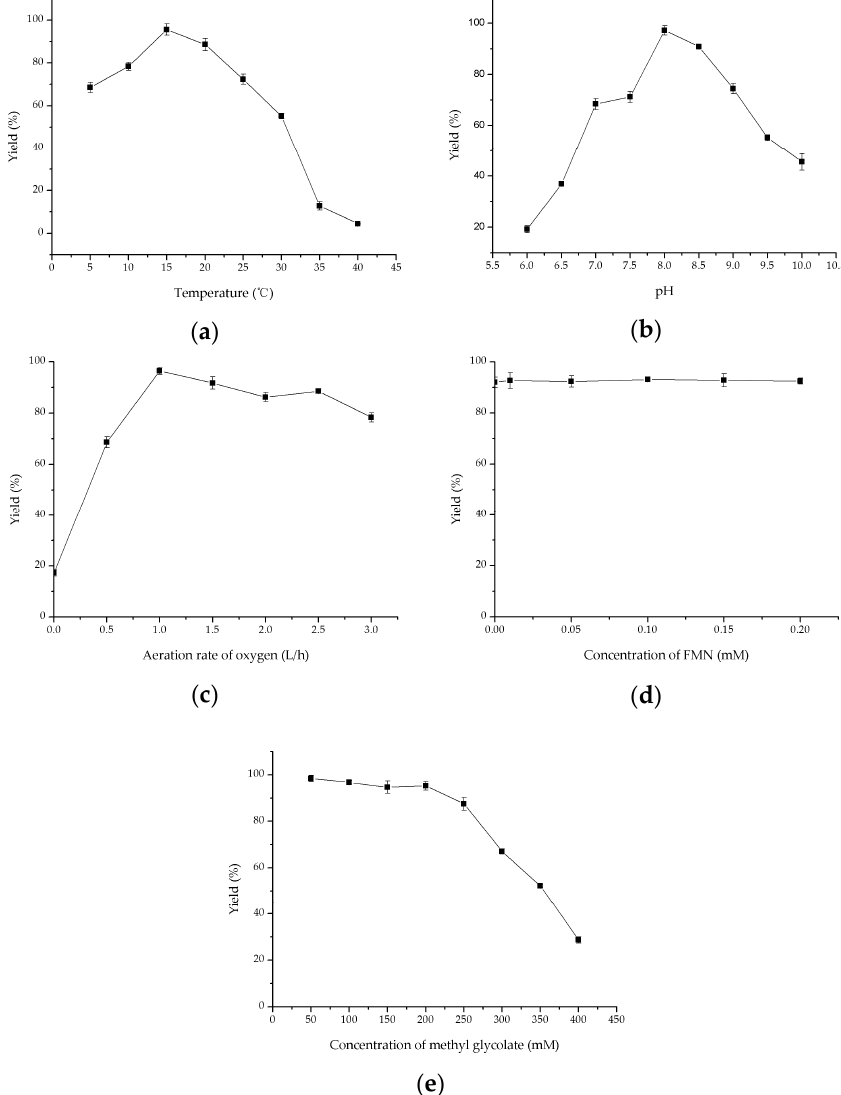
Figure 5. Factors affecting the oxidation of methyl glycolate to methyl glyoxylate: ( a ) Temperature; ( b ) pH; ( c ) the aeration rate of oxygen; ( d ) the concentration of FMN; ( e ) the substrate concentration. The reaction mixture (5 mL) contained 10 mg crude enzyme Vs HGB-GSG- So GOX mut -GGGGS- Hp CAT, 100 mM methyl glycolate, 0.01 mM FMN and 50 mM Tris-HCl (pH 8.0). The reaction at an oxygen aeration rate of 1 L/h was carried out at 15 °C and 600 rpm for 6 h. Then, the factors were individually varied to investigate the effect on the oxidation of methyl glycolate.